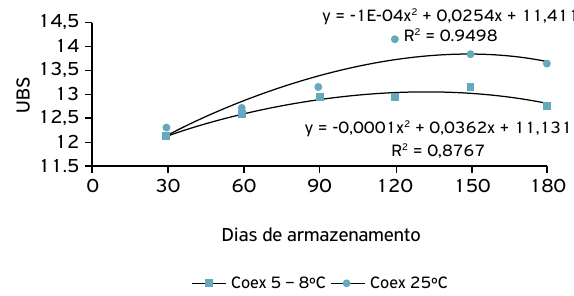
Figura 6. Conteúdo de água (umidade em base seca) de uma mistura granulada com conídios de B. bassiana acondicionada em 3 embalagens tipo Coex durante 180 dias.